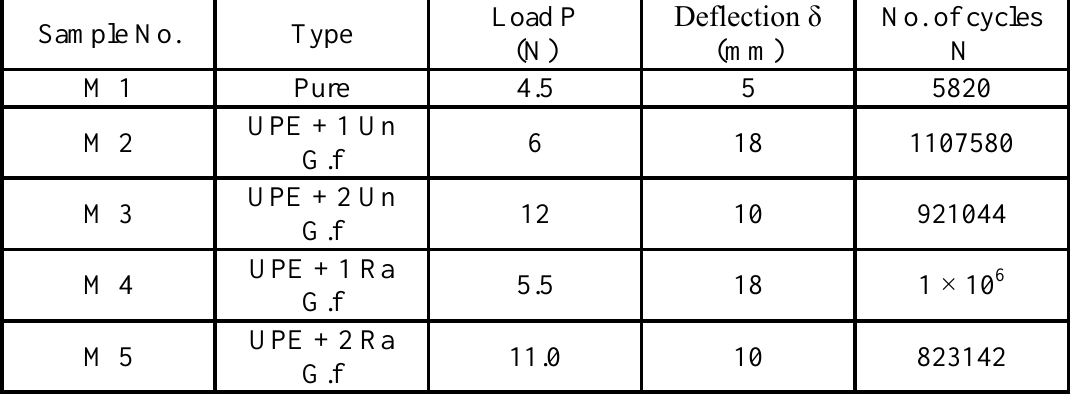
Table (3) : The load, deflection and the number of cycles for unsaturated polyester samples (un Reinforcing and reinforcing with glass fiber at volume fraction 20%.